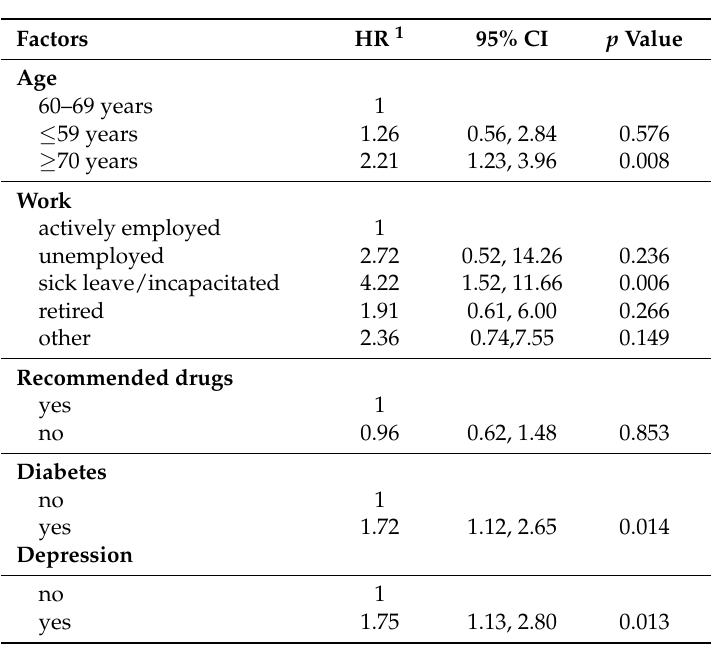
Table 5. This Association between prognosis, measured by the incidence of cardiovascular events (cardiovascular hospital admission or death), and adherence to European clinical practice guidelines (CPGs) and other factors during follow-up.